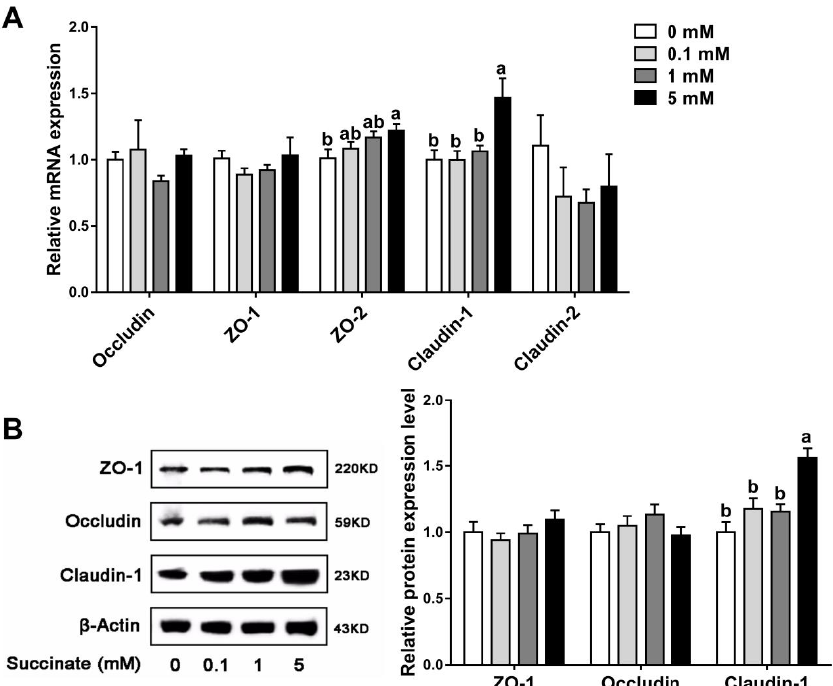
Figure 4. Effects of sodium succinate at different levels on the expression of tight junction proteins in IPEC-J2 cells: ( A ) relative mRNA levels and ( B ) the bands and relative band density of the proteins. Different superscript letters indicate significant differences between groups ( p < 0.05).